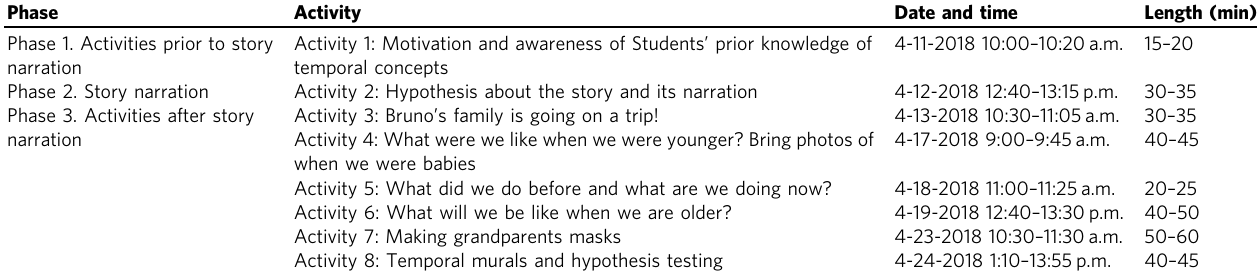
Table 1 Timetables for the